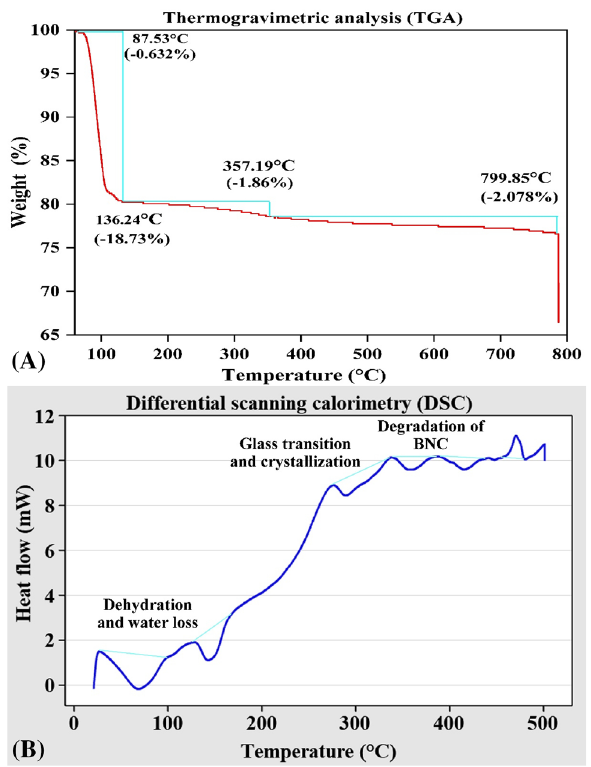
Figure 9. ( A ) Thermogravimetric analysis (TGA), and ( B ) differential scanning calorimetry (DSC) plots of BNC